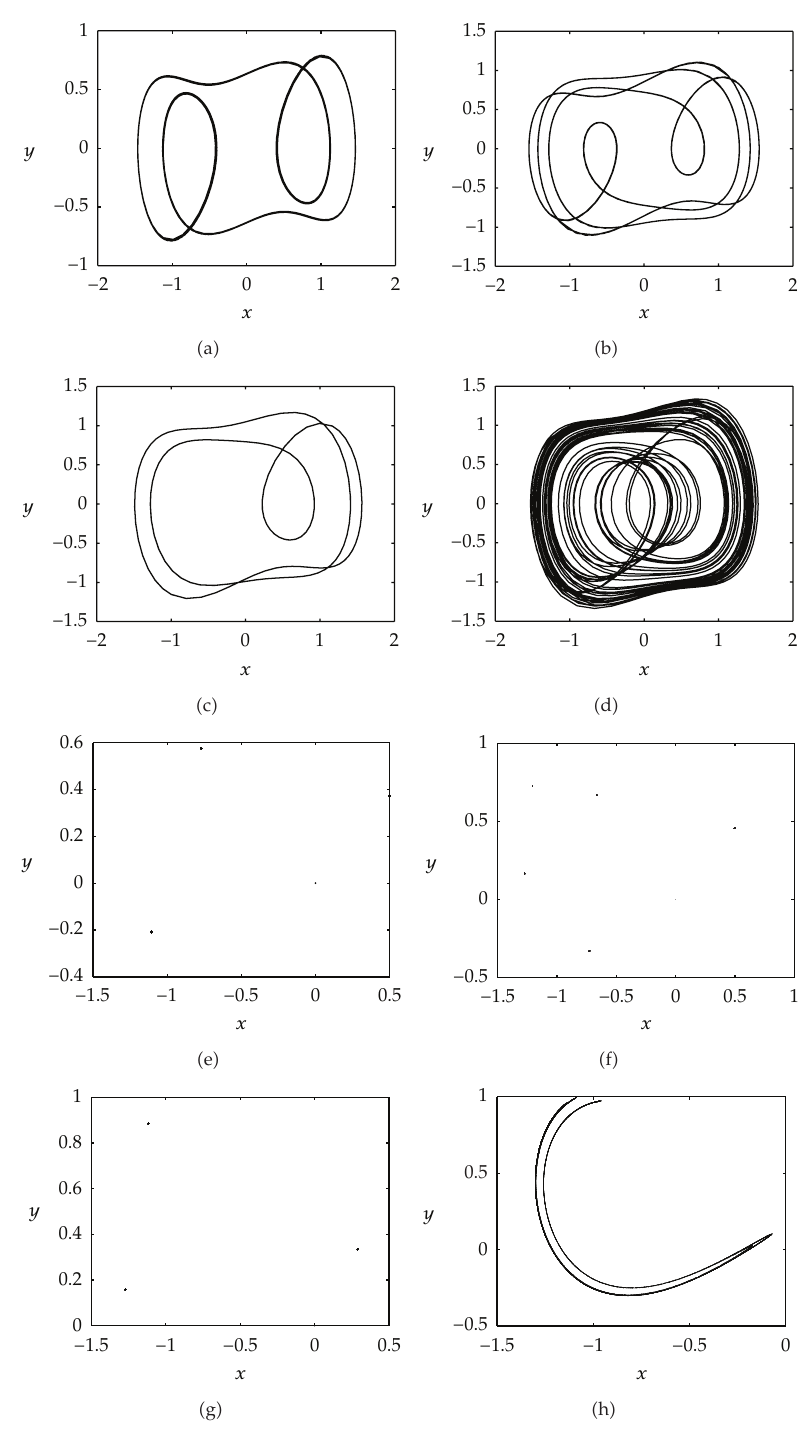
Figure 7: (cid:6) a,b,c, and d (cid:7) Phase portraits of the system (cid:6) 1.6 (cid:7) ; (cid:6) e, f, g, and h (cid:7) Pioncar´e maps of the system (cid:6) 1.6 (cid:7)